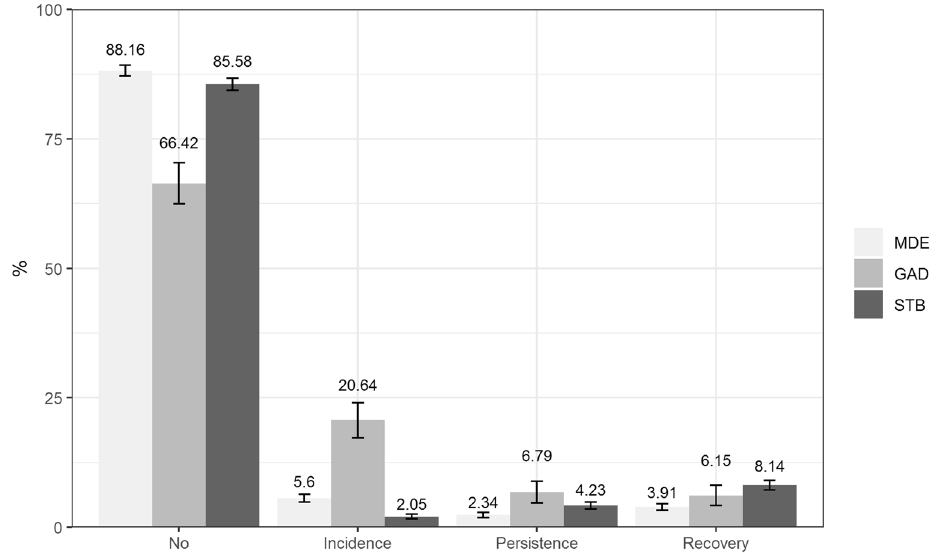
Figure 1. Percentage of sample with No (negative at both assessments T0 and T1), Incidence (negative at T0 but positive at T1), Persistence (positive at both assessments T0 and T1) and Recovery (positive at T0 and negative at T1) of MDE, GAD and any STB before and during the COVID-19. GAD Generalized anxiety disorder; MDE Major depressive episode; STB Suicidal thoughts and behaviors. % weighted follow-up sample weight (inverse probability weighting and post-stratification). Statistical analyses were conducted with 941